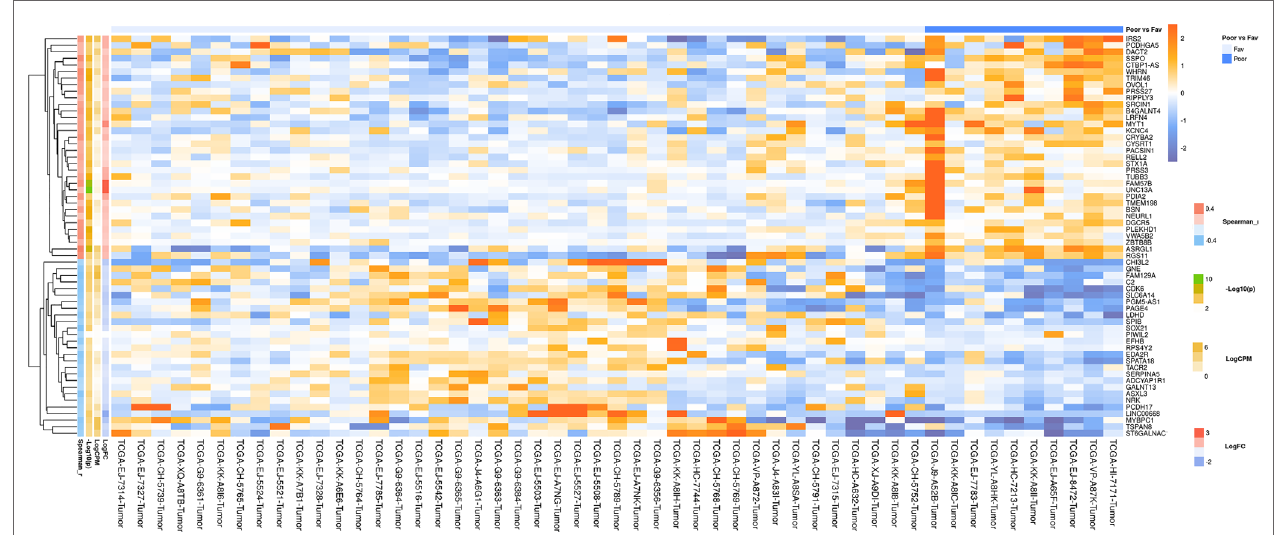
FIGURE 4 | Heatmap demonstrating log relative expression level of top differentially expressed genes between the groups of adverse and favorable prognosis (TCGA data; TMPRSS2-ERG-positive samples). Cell colors (blue-white-orange gradient) correspond the binary logarithm of the ratio of the expression level in a current sample to the average level across all the samples (per each gene). Blue - expression level is below the average, orange - above the average. Spearman_r— Spearman’s rank correlation coefficient. -Log10(p) is the negative logarithm of DESeq’s p -value. LogCPM—average binary logarithm of read counts per million (CPM). LogFC—binary logarithm of expression-level fold change (sample with adverse prognosis compared to favorable